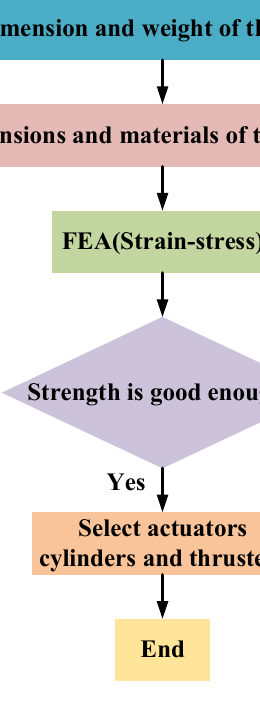
Figure 11. The manipulator assembly.